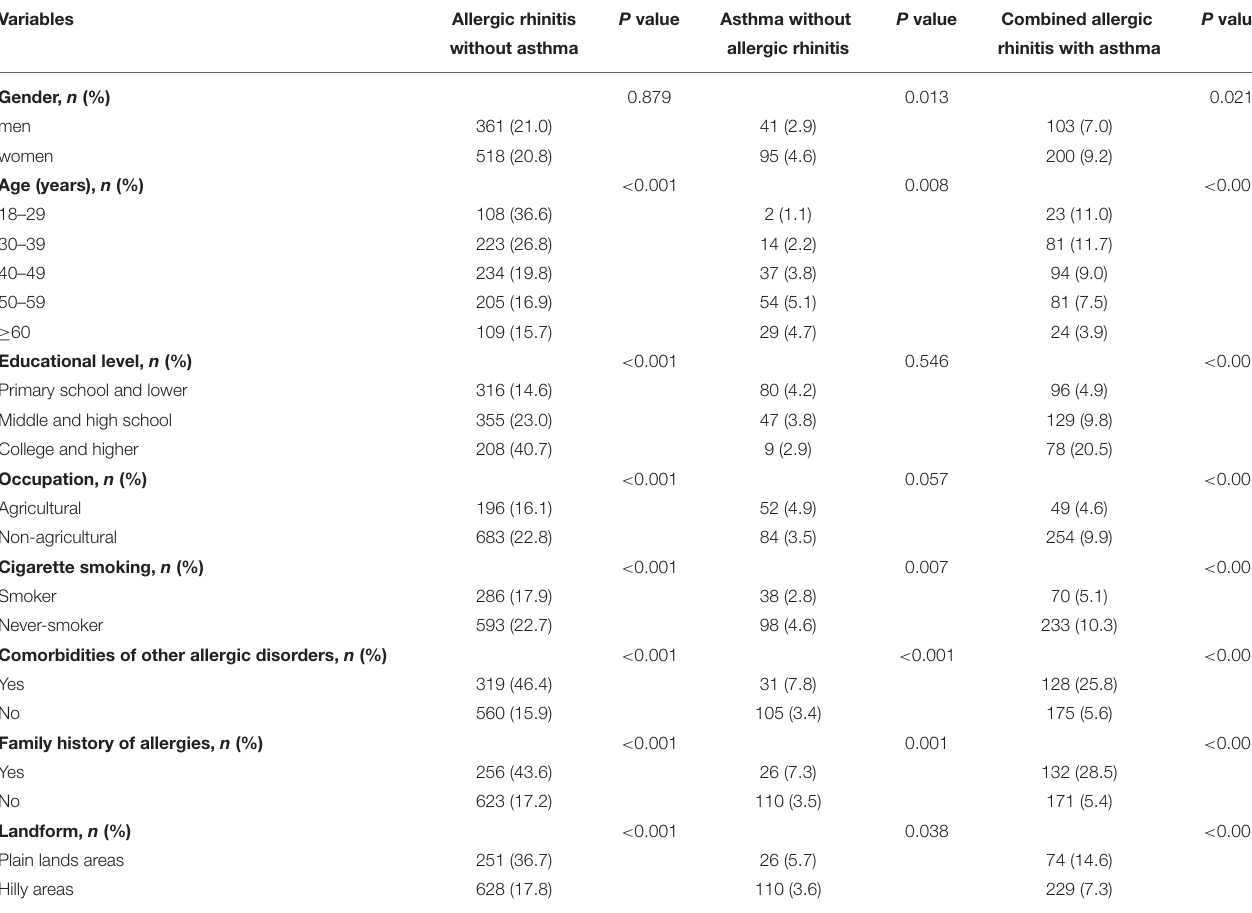
TABLE 2 | Risk factor analysis of the allergic rhinitis without asthma, asthma without allergic rhinitis, and combined allergic rhinitis with asthma. Variables Allergic rhinitis P value Asthma